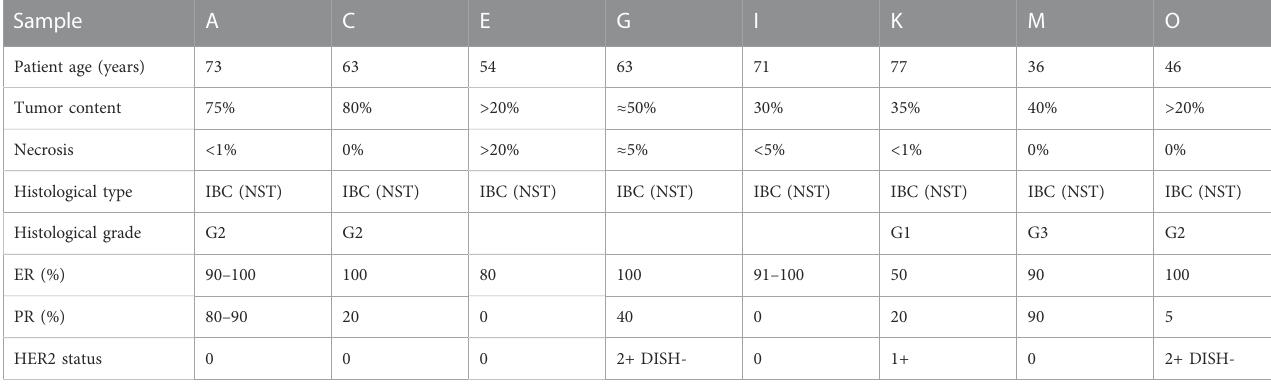
TABLE 1 Characteristics of the ER+/HER2-breast carcinoma samples included in the fi rst PIK3CA testing round.